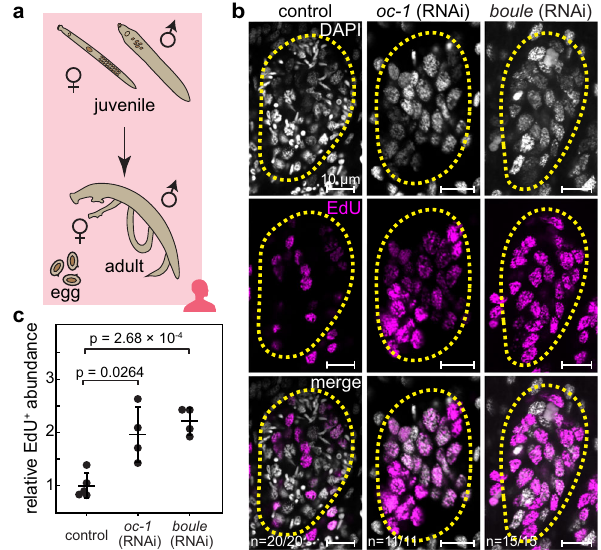
Fig. 4 Knockdowns of boule and oc-1 cause male GSC over-proliferation in adult parasites. a Schematic of the sexual maturation process from juveniles to adults, which mate and lay eggs. b Confocal images showing representative individual testis lobules stained by DAPI and EdU in adult parasites after control, oc-1 , and boule RNAi. Dashed circles: testis lobule boundary. Note a signi fi cant increase of EdU + nuclei and a marked reduction of differentiated germ cells. n : number of samples exhibiting the reported phenotype out of the total number of samples analyzed. c Since accurate counting of germ cells, which are densely packed in adult testes, is challenging, the number density of EdU + nuclei per unit image area in testes normalized against the abundance in control parasites is quanti fi ed instead. N = 5 (control RNAi); N = 4 ( oc-1 RNAi); N = 4 ( boule RNAi). Data are plotted as average ± standard deviation and p -values are calculated using two-sided Welch ’ s t -test. RNAi experiments were repeated on at least three biological